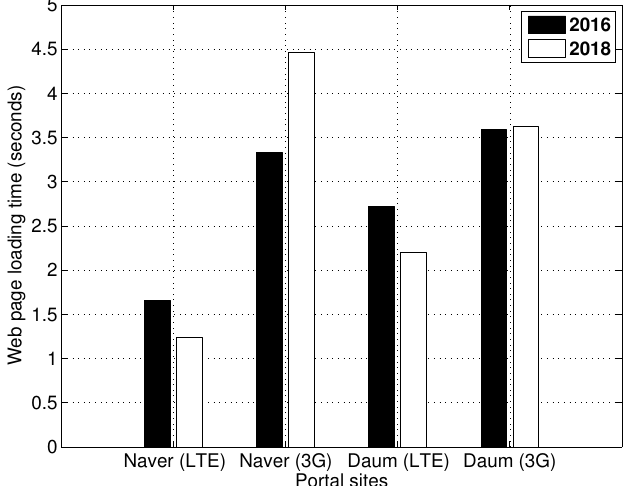
Figure 5. Web page loading times for LTE and 3G networks in 2016 and